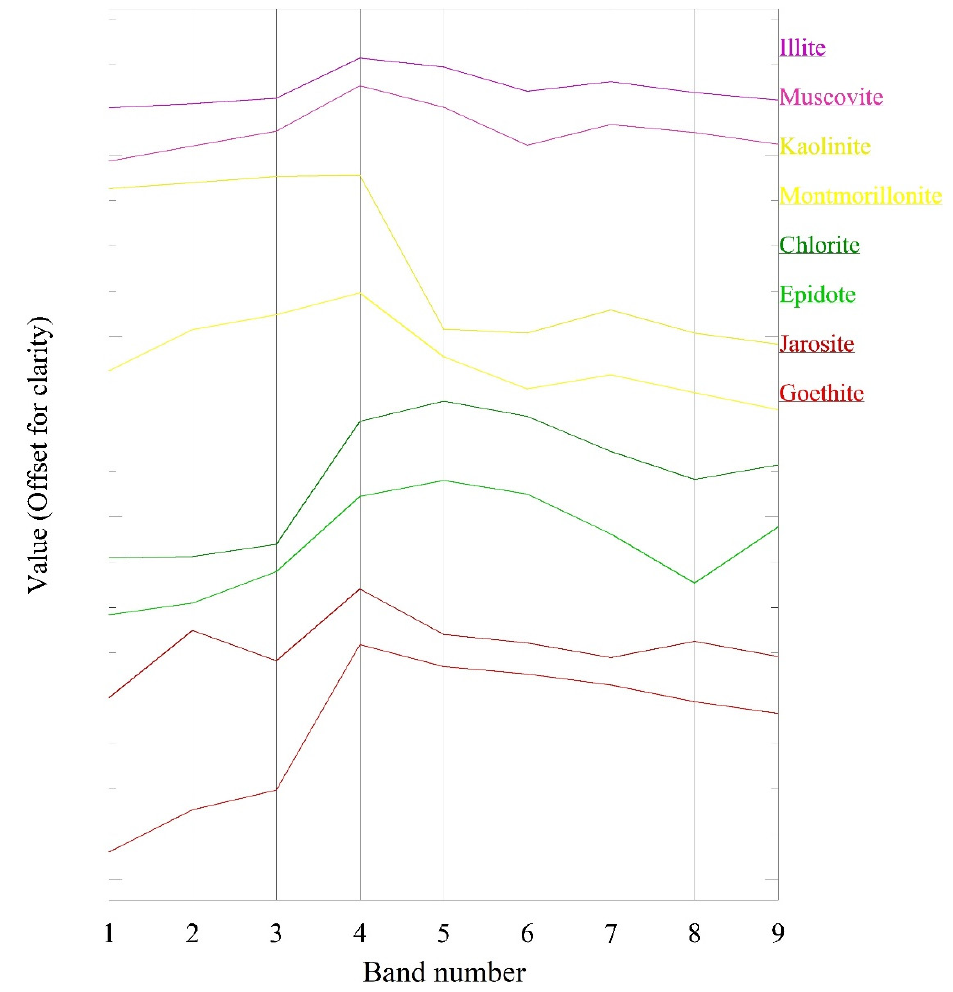
Figure 4. The spectral signatures (reflectance spectra) of indicator alteration minerals selected from the USGS spectral library that was re-sampled to the ASTER band-passes.